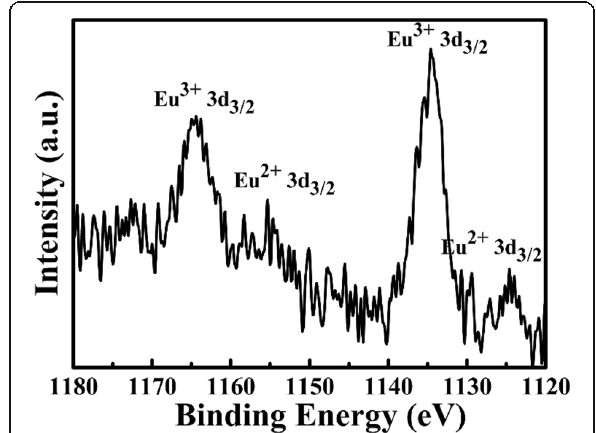
Fig. 4 XPS spectrum for Eu element of the zeolite-3A: 1.3 wt% Eu phosphors sintered at 1400 °C for 3 h